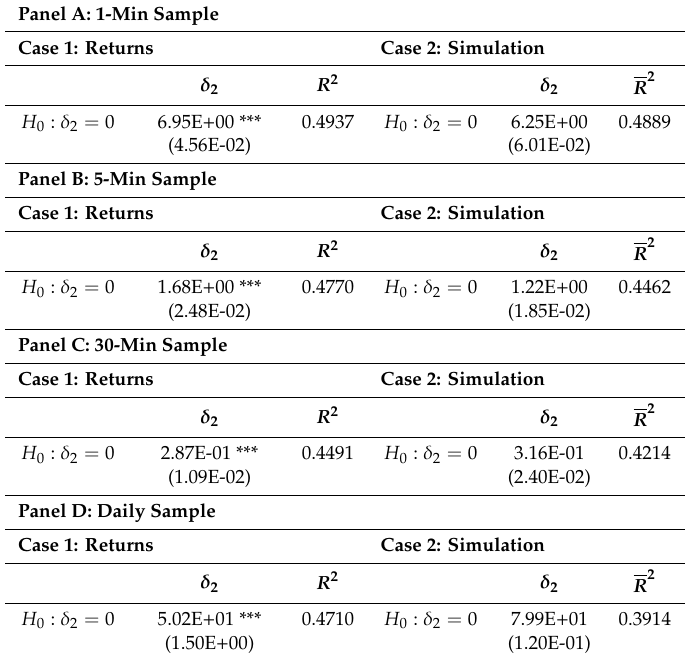
Table 3. Estimation results for the stochastic volatility of